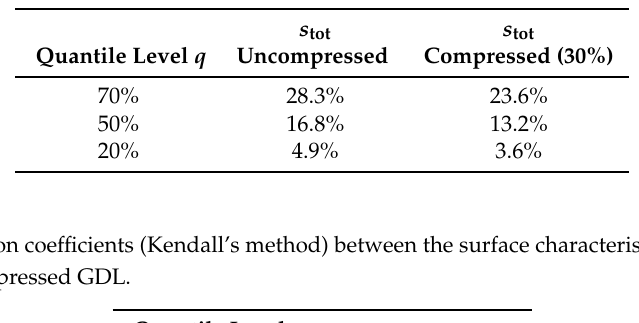
Table 5. Total quantile areas s tot related to the total surface of 590,000 µm 2 , uncompressed and compressed (30%) GDL.